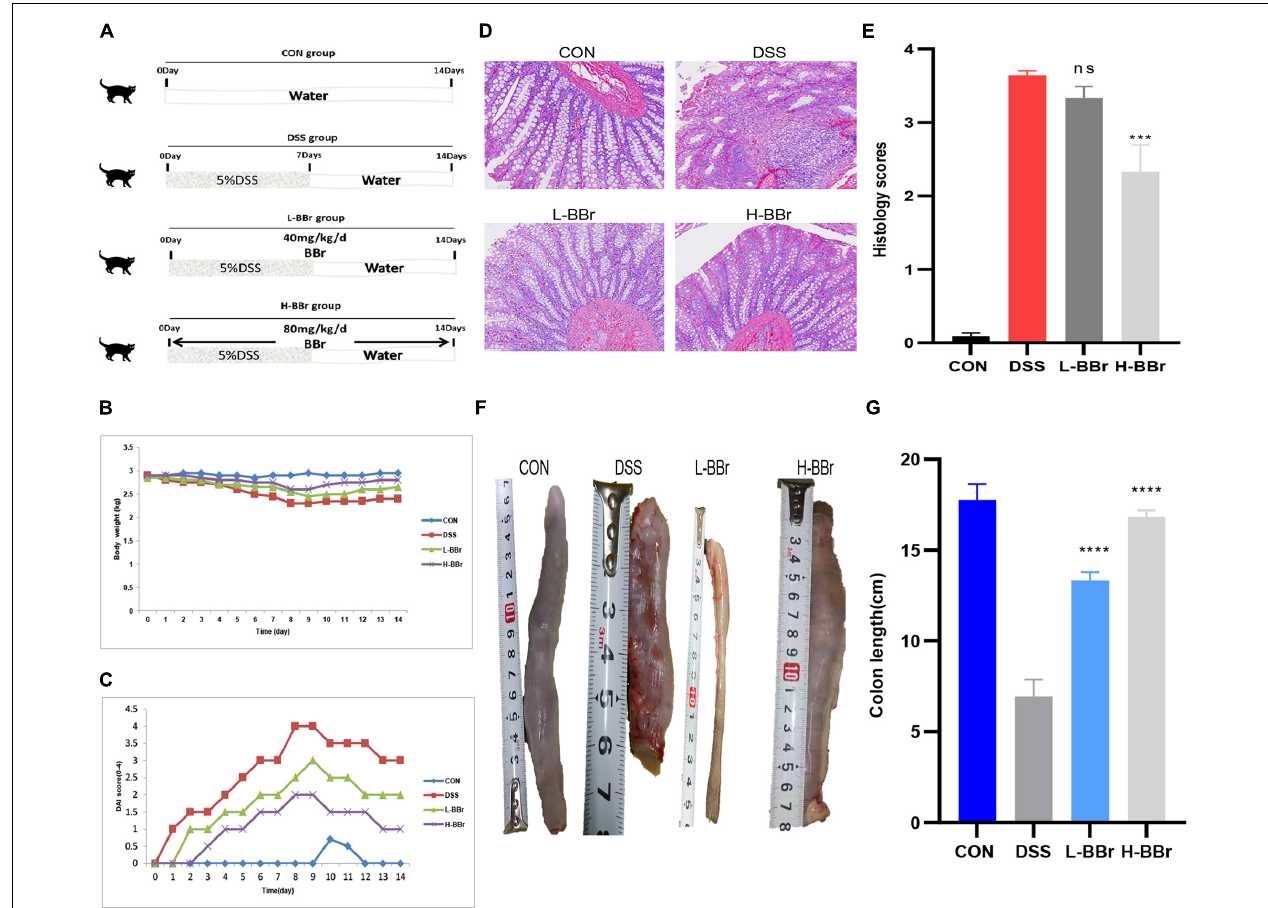
FIGURE 1 | BBr exerted protective effects in DSS-induced IBD. (A) Graphical presentation of the study design. Intestinal inflammation is induced by administrating 5%DSS for 7 days and then replaced with pure water. Cats in the BBr group received BBr (40 and 80 mg/kg) orally for 14 days, and the vehicle group was left untreated. Bodyweight (B) and DAI score (C) monitor every day. (D) HE stained. (E) Colonic mucosal damage score. (F) Representative necropsy photographs of the colon. (G) Colon length. All data are present as mean ± SD . P < 0.05 was considered statistically significant, and *** P < 0.001, **** P < 0.0001 vs. the DSS group. CON, the control group, cats with no treatment; DSS, cats treated only with 5%DSS; L-BBr, cats treated with both 5%DSS and 40 mg/kg/day BBr; H-BBr, cats treated with both 5%DSS and 80 mg/kg/day